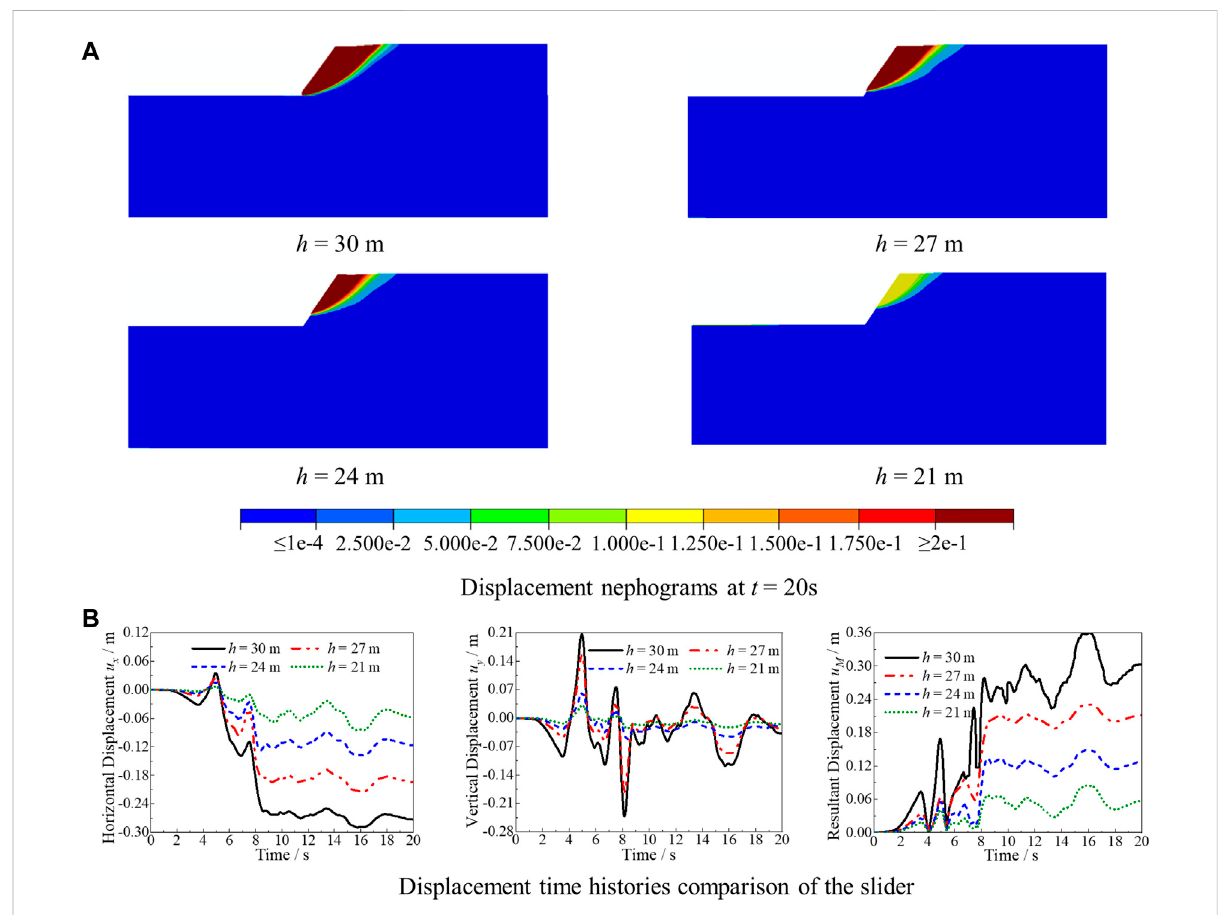
FIGURE 11 Displacementoftheslopeatdifferentinterfacepositionsofsoftandhardrock. (A) Displacementnephogramsat t =20 s. (B) Displacementtime history comparison of the slider.